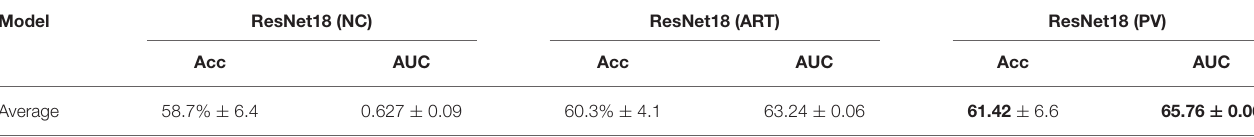
TABLE 7 | Comparison of single-phase ResNet18 backbone